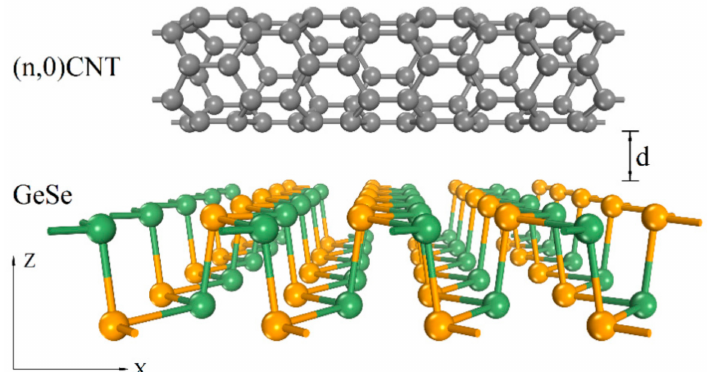
Figure 1. Schematic diagram of the side view of different zigzag CNTs ( n ,0) ( n = 5–11) on monolayer GeSe. C, Ge, and Se atoms are represented by gray, green, and orange spheres, respectively. d is the interfacial spacing between the CNT and monolayer